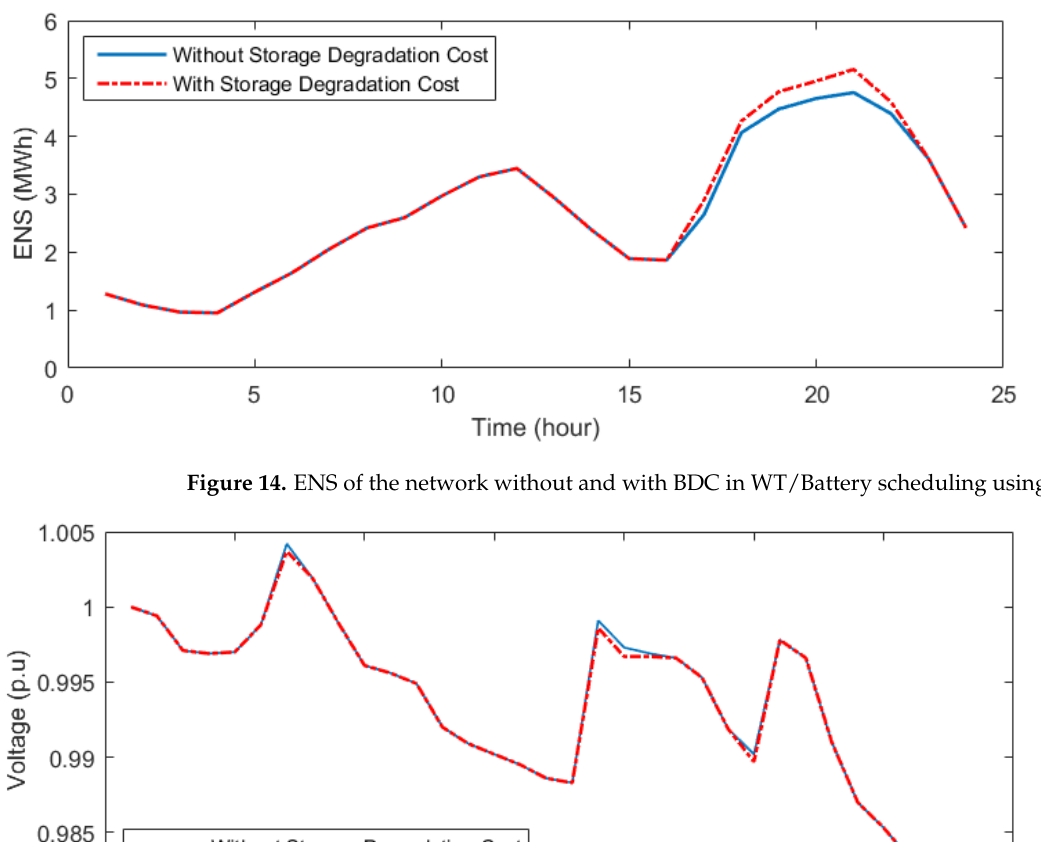
uling using the Figure 15. Voltage profile of the network by considering/neglecting the BDC in WT/Battery sched-